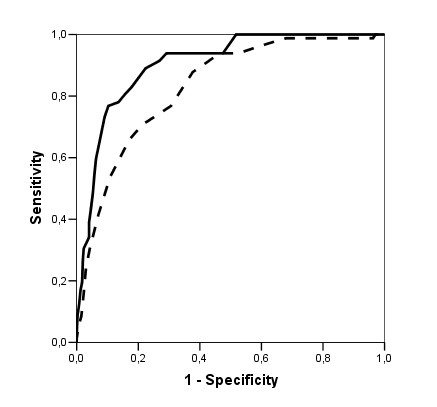
ROC curve as a measure of diagnostic accuracy of the Eurotest (solid line) and the Verbal Fluency Test (dashed line) in identifying dementia